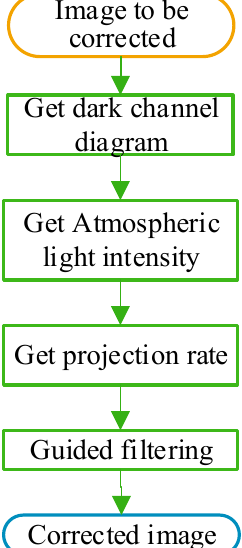
Figure 2. Atmospheric correction process based on dark channel prior theory.